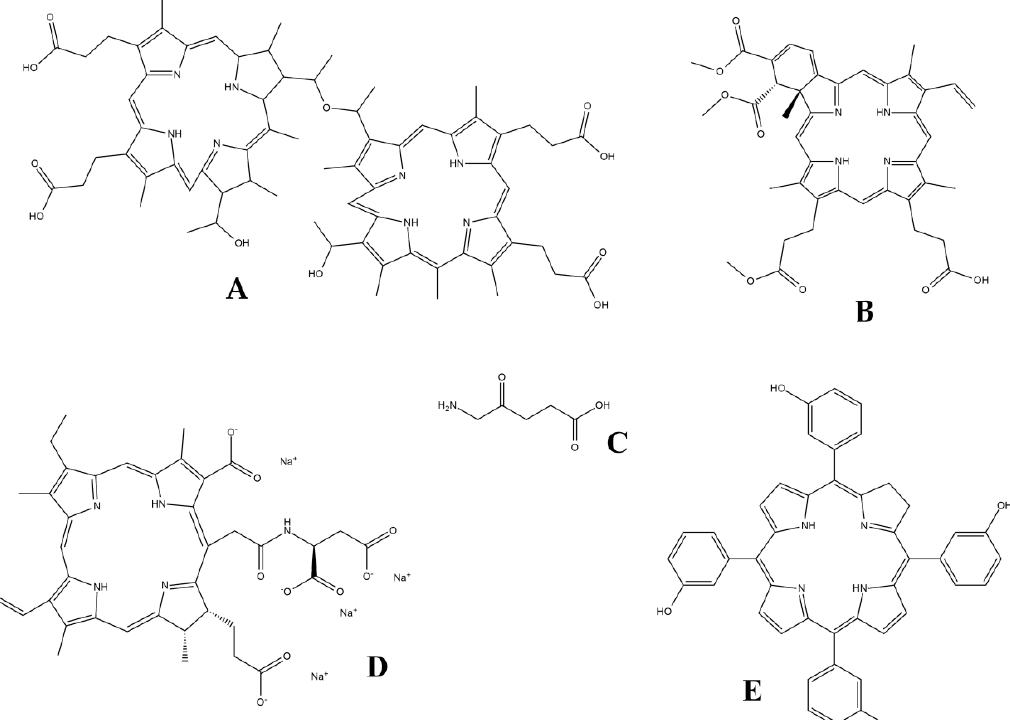
Figure 1. Examples of clinically relevant photosensitizer (PS) compounds. A : Photofrin ® (hematoporphyrin or dihematoporphyrin ether); B : Visudyne ® (verteporfin); C : 5-aminolevulinic acid (ALA); D : talaporfin sodium (LS11); and E : Foscan ®